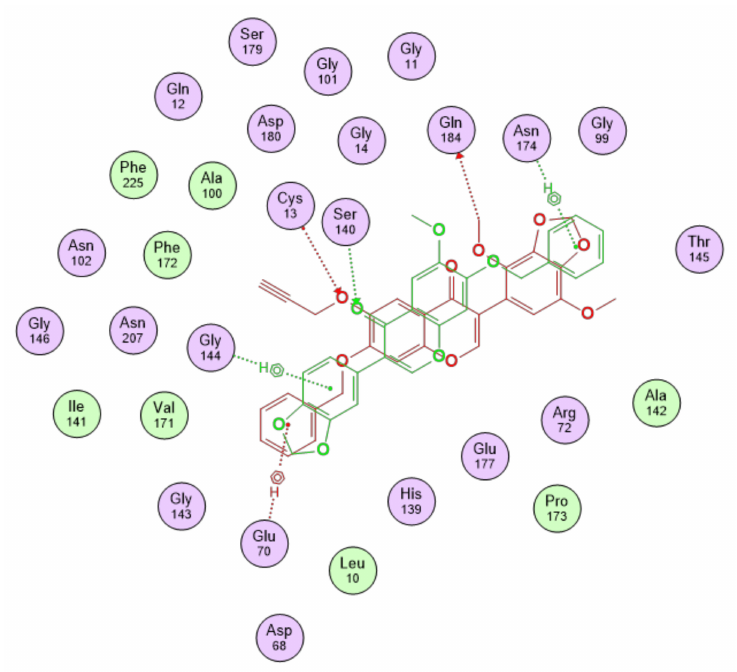
Figure 9. Binding interactions of gatastatin G2, represented in red, and S3 derivative, shown in green, with γ tubulin in the GTP-binding site.